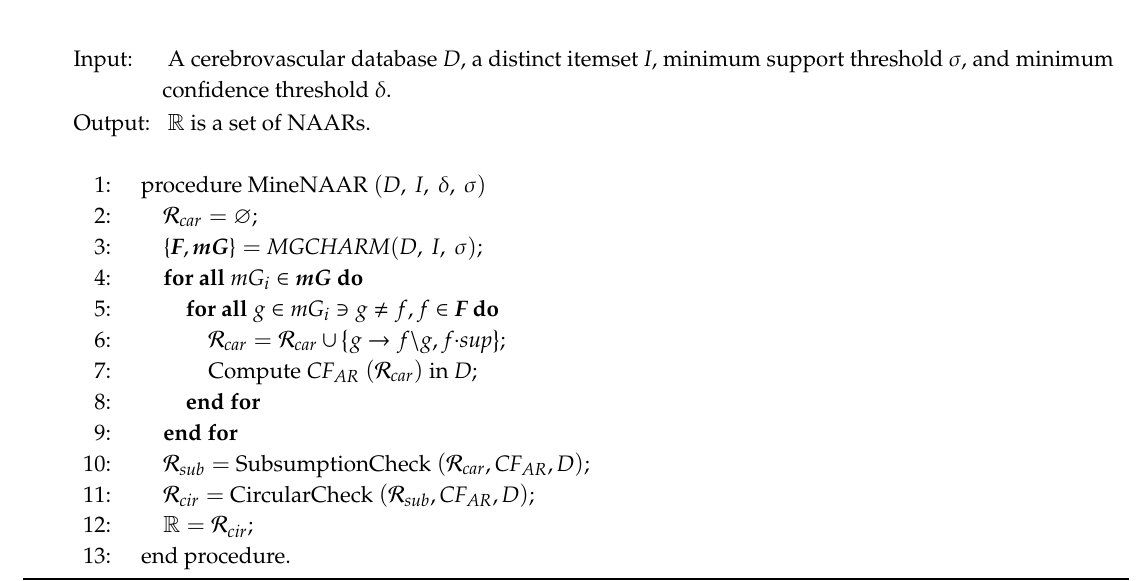
Algorithm 1 NAARs